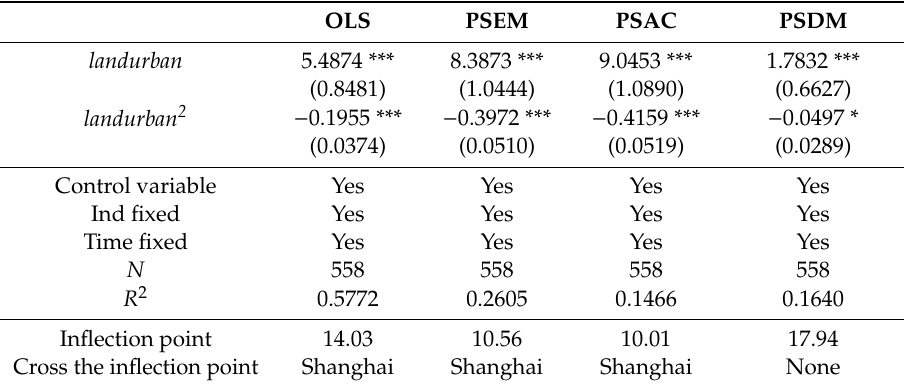
Table 5. Estimated results of di ff erent